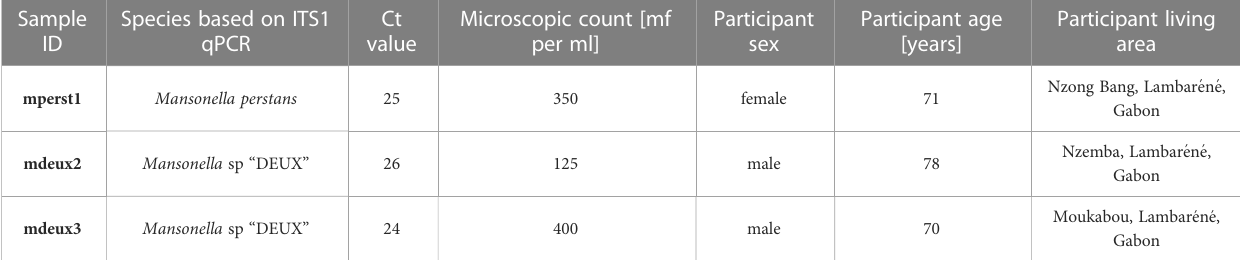
TABLE 1 Infection status, parasitemia and demographic data of individuals for mperst1, mdeux2 and mdeux3. Sample